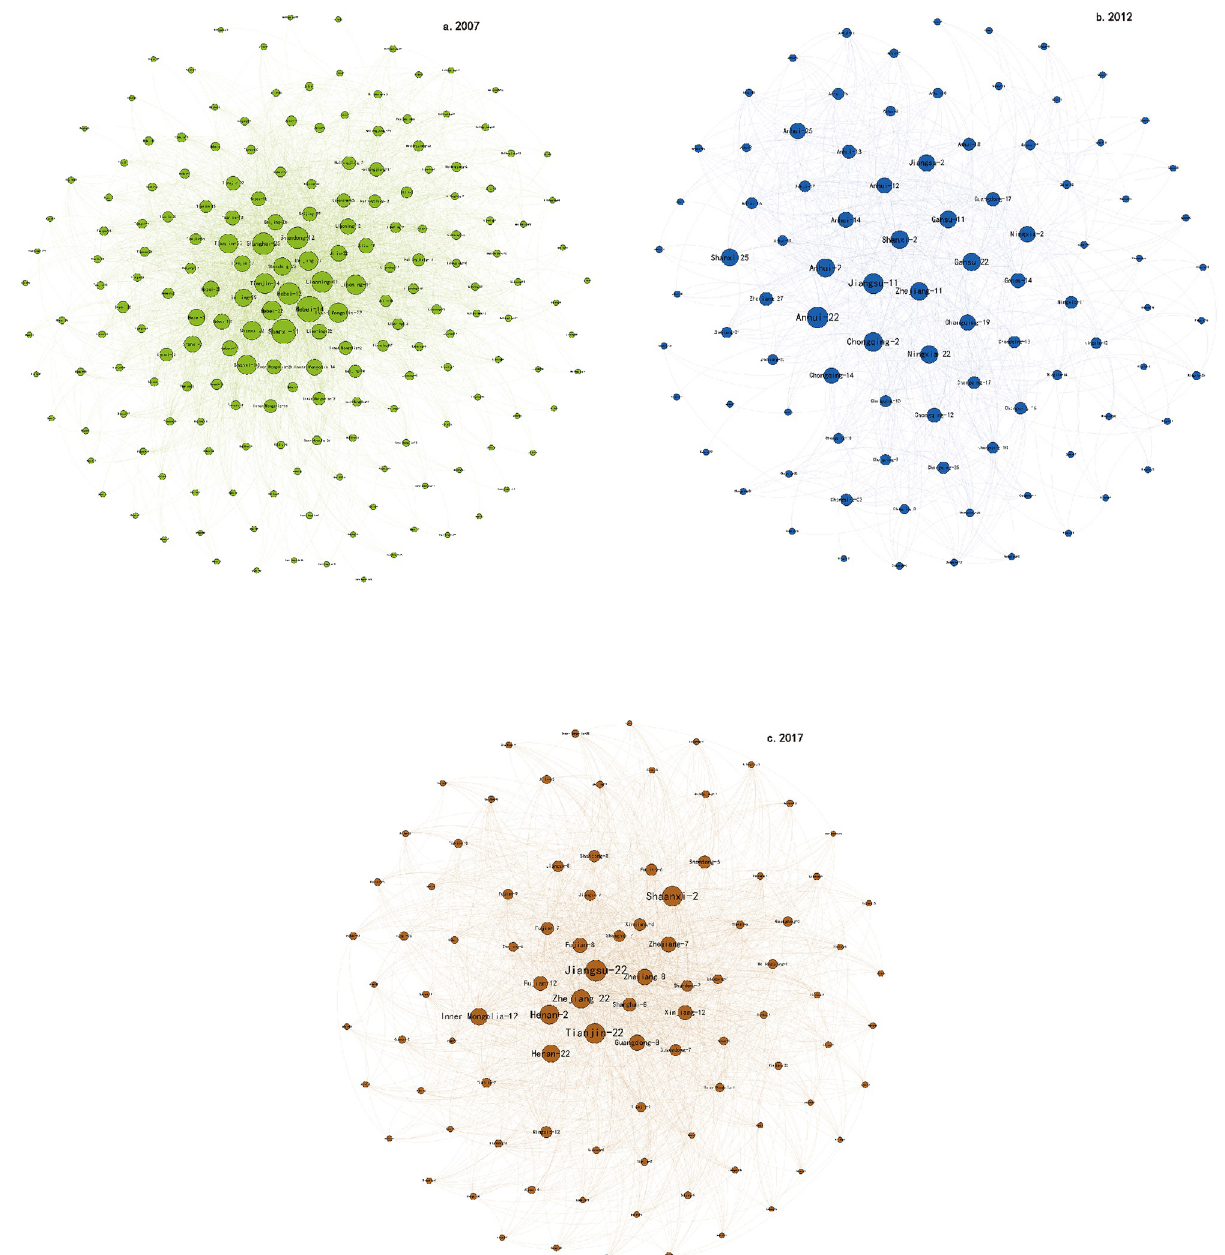
Fig 3. First network communities in 2007, 2012 and